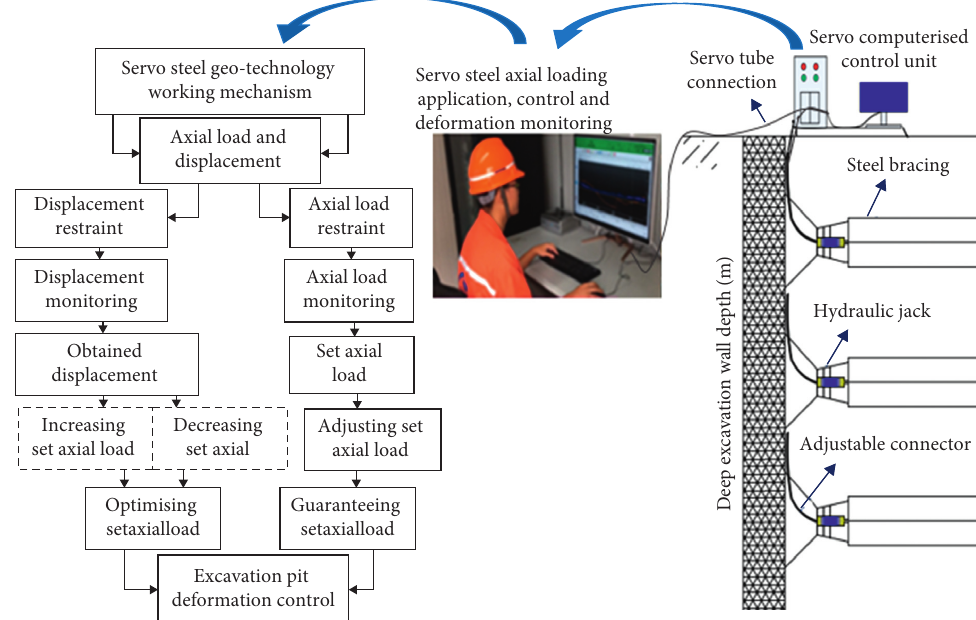
Figure 2: Field construction site application arrangement showing the working principle and mechanism of servo steel enhancement geotechnology.